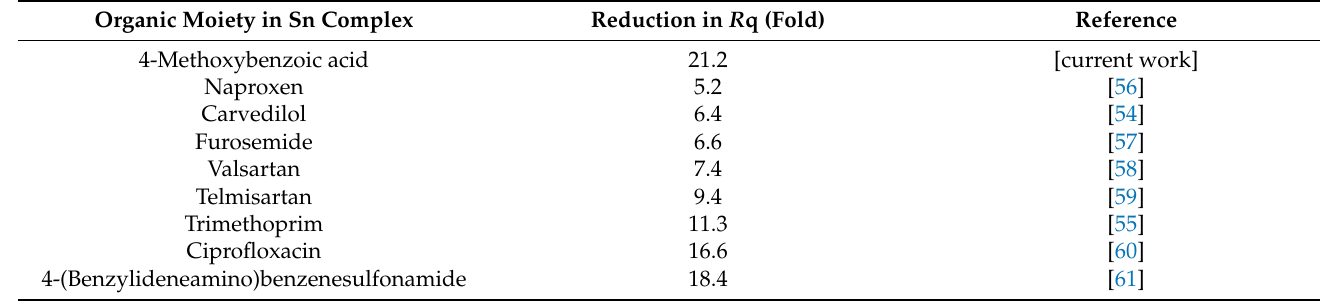
Table 4. Reduction in the roughness factor R q (by fold) of PVC films in the presence of various Sn complexes. Organic Moiety in Sn